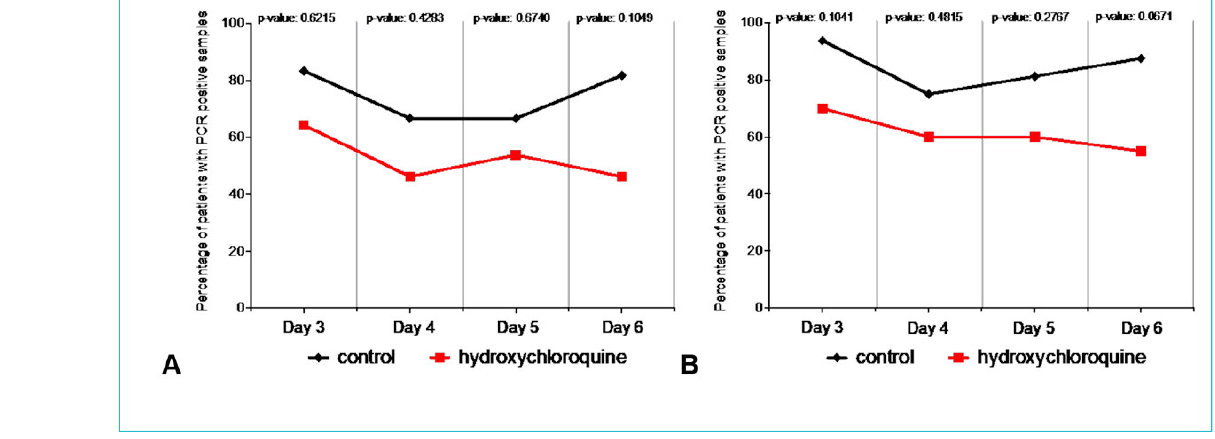
Figure 1: Gautret et al. [1] differences in PCR testing results between patient-groups are not significant when excluding missing patient data or using an intention-to-treat model for data analysis. (A) Percentage of patients with PCR-positive nasopharyngeal samples from day 3 to day 6 post-inclusion from control and hydroxychloroquine-treated groups, exclusive of all missing datasets. Multiple Fisher’s exact tests revealed no significant differences between the groups on any of the analysed treatment days. (B) Percentage of patients with PCR-positive nasopha- ryngeal samples from day 3 to day 6 post-inclusion from control and hydroxychloroquine-treated groups, inclusive of all patients using an in- tention-to-treat design. Multiple Fisher’s exact tests revealed no significant differences between the groups on any of the analysed treatment days. All statistical analysis was performed using Prism 8